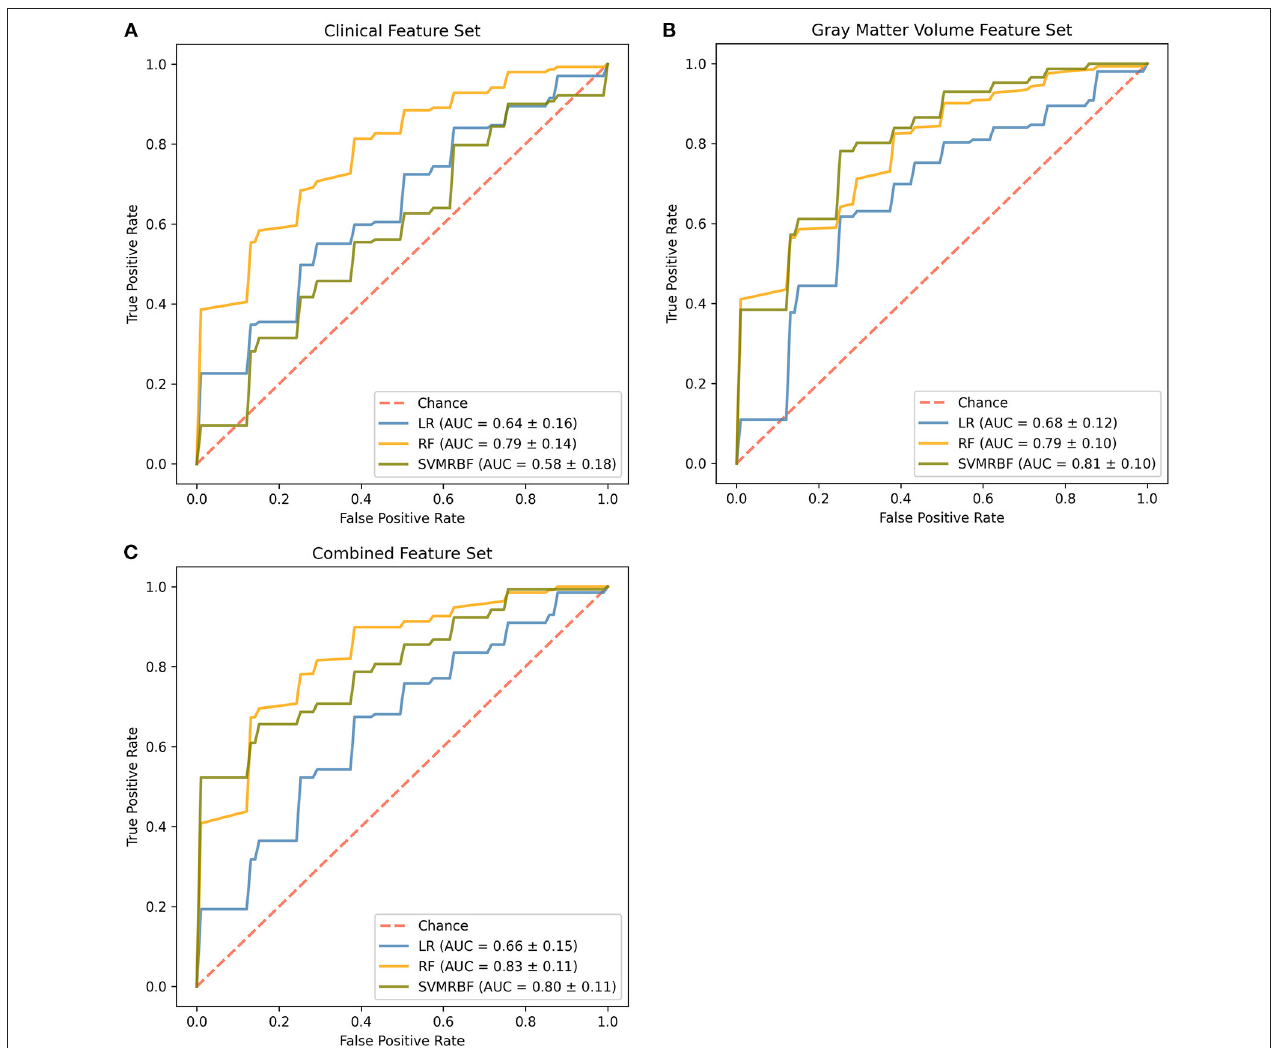
FIGURE 1 | Comparison of classifiers by algorithm and feature set. Evaluated feature sets included (A) sociodemographic and clinical features only, (B) gray matter volumes only, or (C) a combination of all available features. Features were ranked by feature importance and the top 20 from each feature set used for classifier training. The final mean cross-validated area under the cover (AUC) scores are shown for the Logistic Regression (LR, blue), Random Forest (RF, gold), and Support Vector Machine-Radial Bias Function (SVMRBF, olive) classifiers.